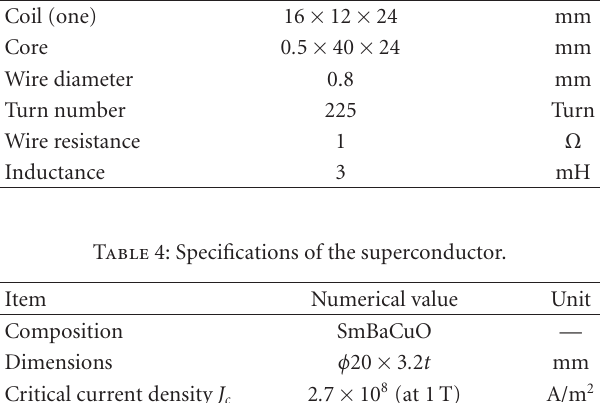
Figure 8: Magnetic flux density at the surface of superconductor magnetized in the same direction.